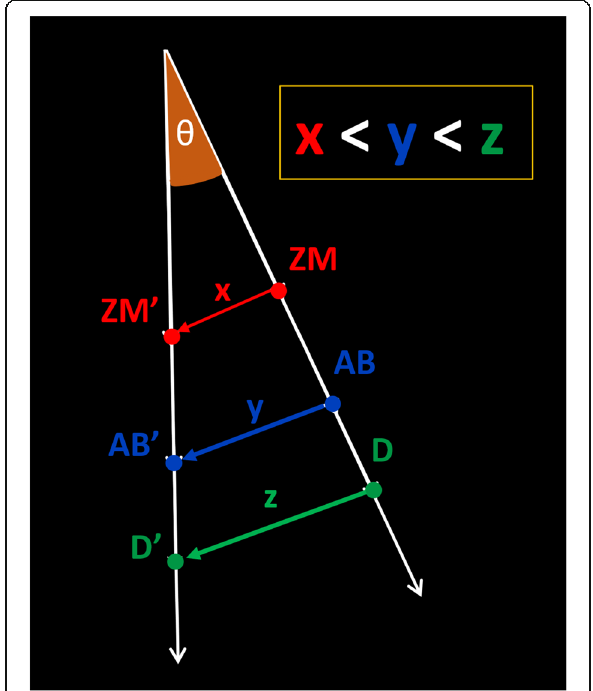
Fig. 8 Diagram displaying the inaccuracy of using linear measurements in order to assess rotational pattern movement. For the same angle θ , points closer to the fulcrum experience a shorter linear displacement than points farther from the fulcrum. ZM, pre- expansion zygomaticomaxillary point; ZM ’ , post-expansion zygomaticomaxillary point; AB, pre-expansion alveolar bone point; AB ’ , post-expansion alveolar bone point; D, pre-expansion dental point; D ’ , post-expansion dental point; x , linear skeletal distance; y , linear alveolar bone distance; z , linear dental distance